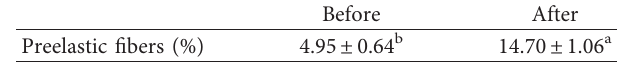
Table 1: Morphometry of epidermis and dermal papillae and area of connective fibers before and after treatment. Before After Preelastic fibers